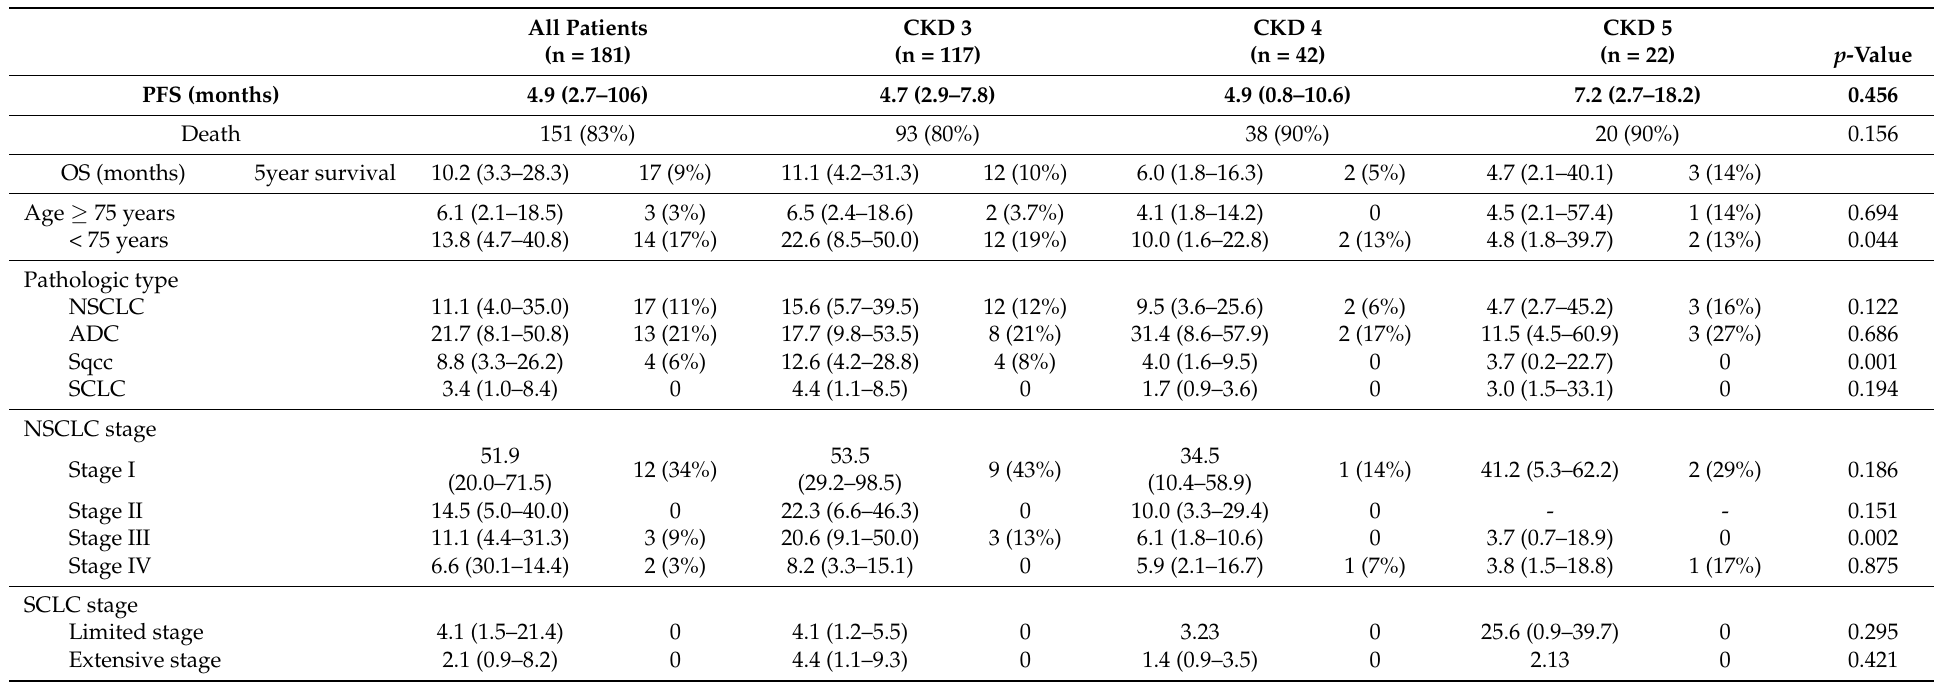
Table 2. Clinical outcome of lung cancer patients with chronic kidney